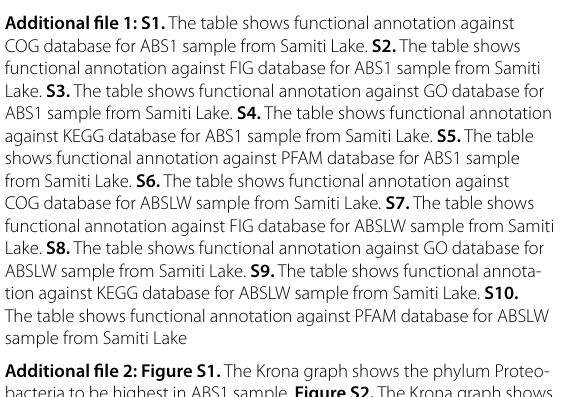
Additional file 2: Figure S1. The Krona graph shows the phylum Proteo- bacteria to be highest in ABS1 sample. Figure S2. The Krona graph shows the phylum Proteobacteria to be highest in ABSLW